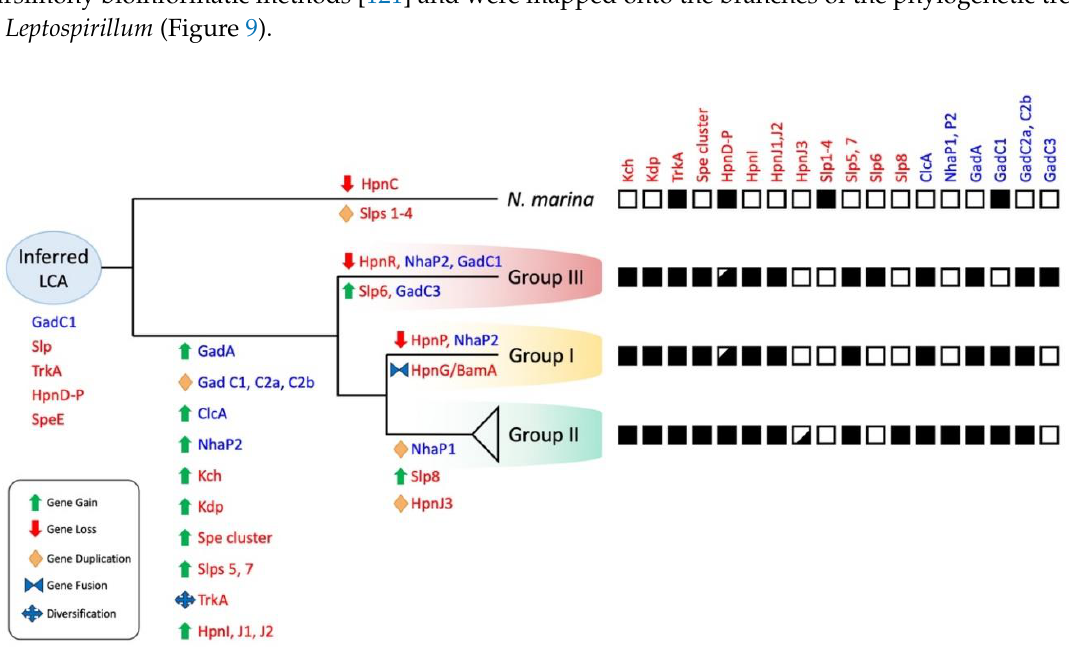
Figure 9. Inferred evolutionary reconstruction of the acid related genes of Leptospirillum with the main evolutionary events (gene gain/loss/fusion/duplication). Parsimony was used for the inferences. Names in red = first line of defense mechanisms and blue = second line of defense mechanisms. Black square = presence and white square = absence of mechanism. Black squares with white sections = mechanism is present in some, but not all, strains. LCA = last common ancestor.